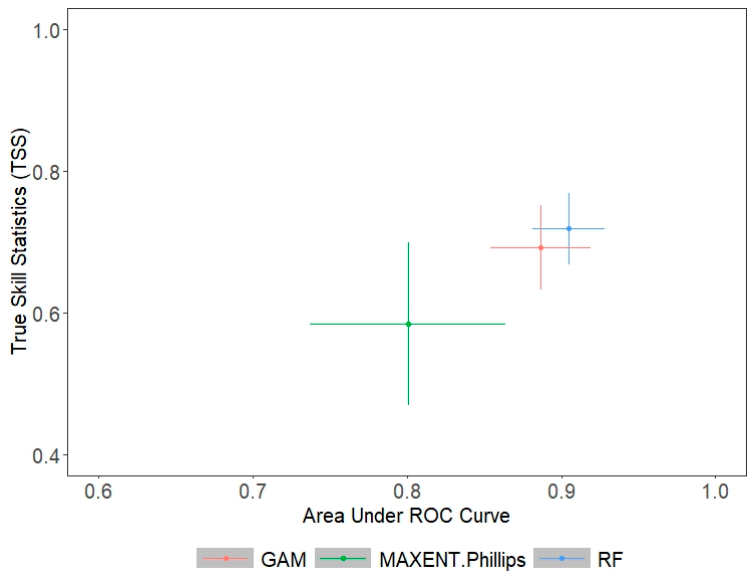
Figure A6. The initial model evaluation for the models from the RS data. Among the 120 models, the models which have True Skill Statistics and Area Under ROC scores greater than 0.7 and 0.8 respectively were only considered in habitat suitability modelling.